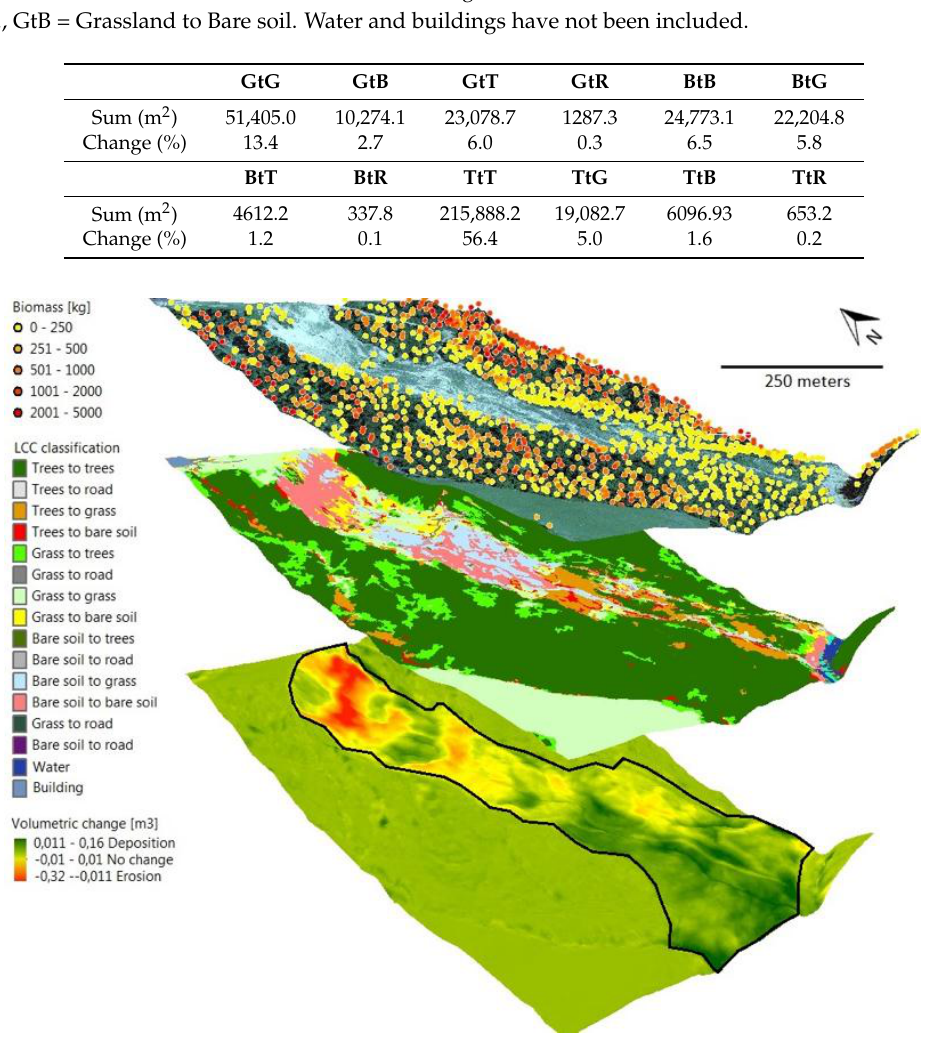
Table 4. Quantification of relative land-cover change (LCC) per land-cover class. The total surface area is 382,550 m 2 .